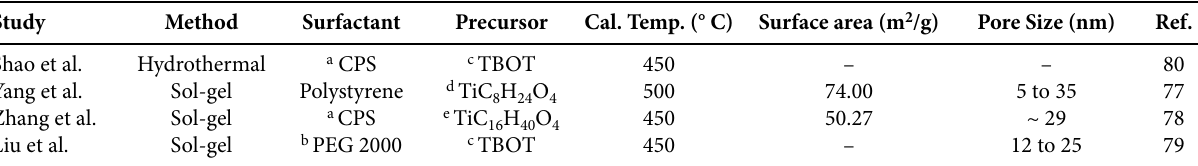
Table 3. Summary of preparation methods using PFA as SDA.